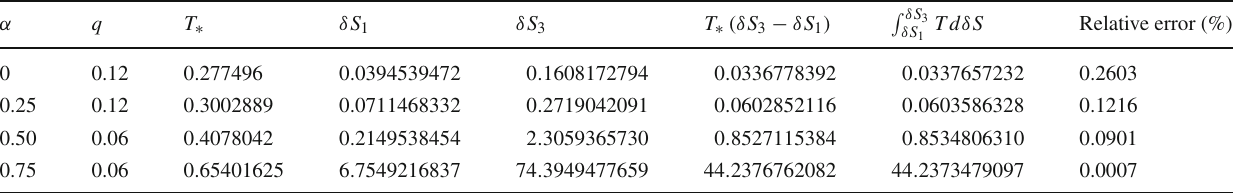
Table 7 Numerical check of equal area law in T – δ S graph for n = 3 ,θ 0 = 0 . 3 , l = 1 , b = 1 , k = 1